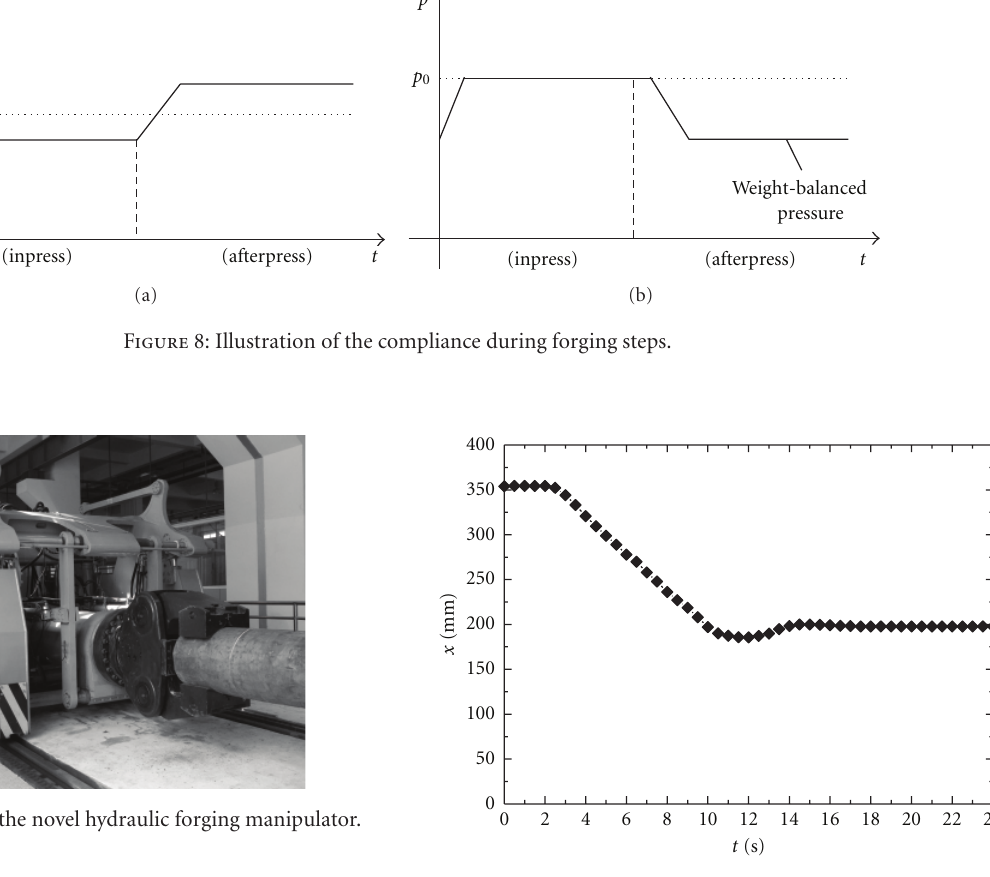
Figure 11: Position curve in lifting